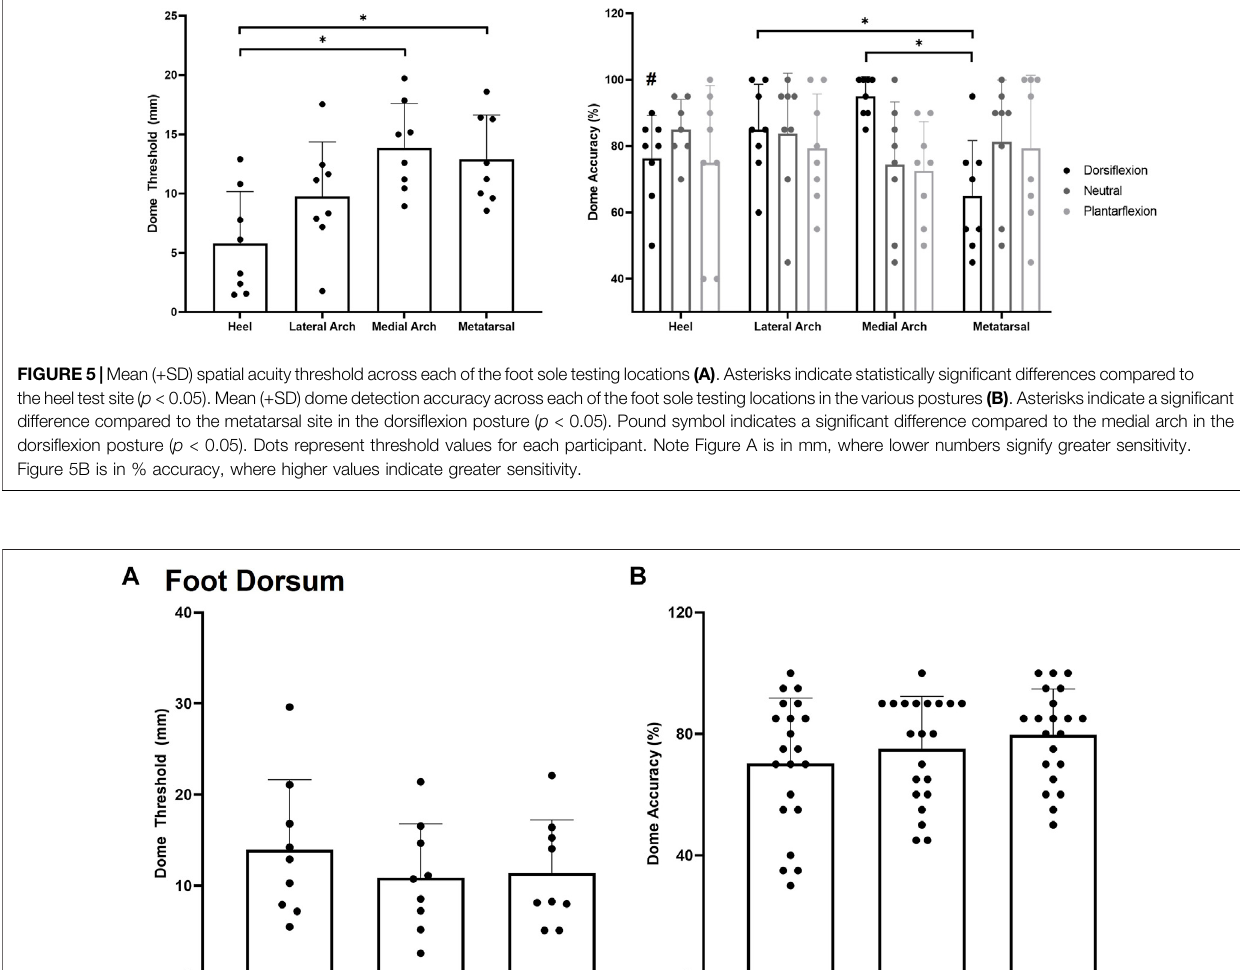
( Figure 4B ) were observed for mono fi lament threshold. The